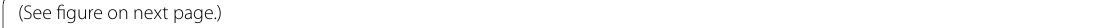
figure on next Fig. 9 Bivariate plots of conch parameters and septal spacing (of the last half volution) in the Late Tournaisian assemblage of Oued Temertasset (grey background dots represent the entire sample). A , D , G , J , M Conch width index (ww/dm) and septal spaces. B , E , H , K , N Whorl width index (ww/wh) and septal spaces. C , F , I , L , O Whorl expansion rate (WER) and septal spaces. A – C Complete assemblage. D – F Family Prionoceratidae. G – I Family Pericyclidae. J – L Family Muensteroceratidae. M – O Family